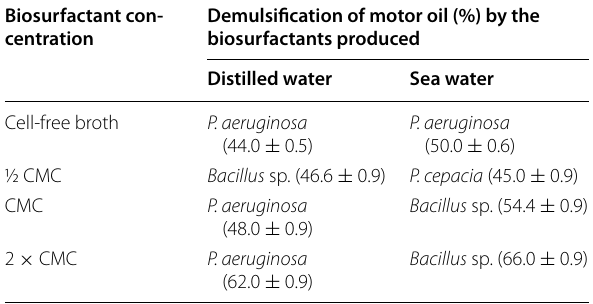
Table 2 Demulsification percentage of motor oil emul- sions in distilled water and in sea water after addition of